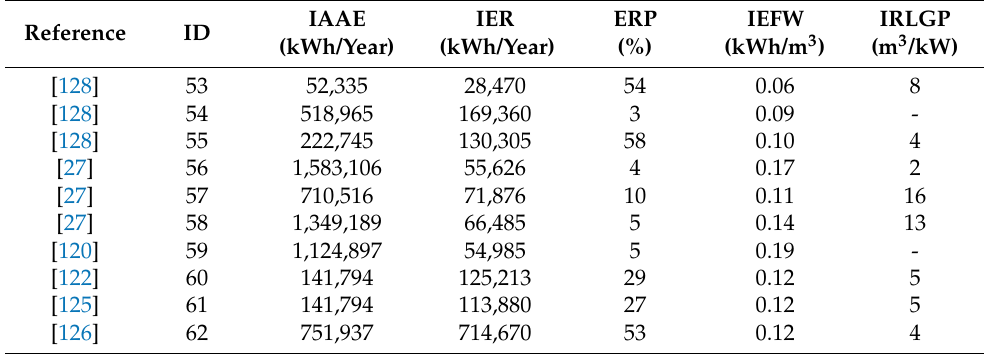
Table 10. Calculable energy indices with available